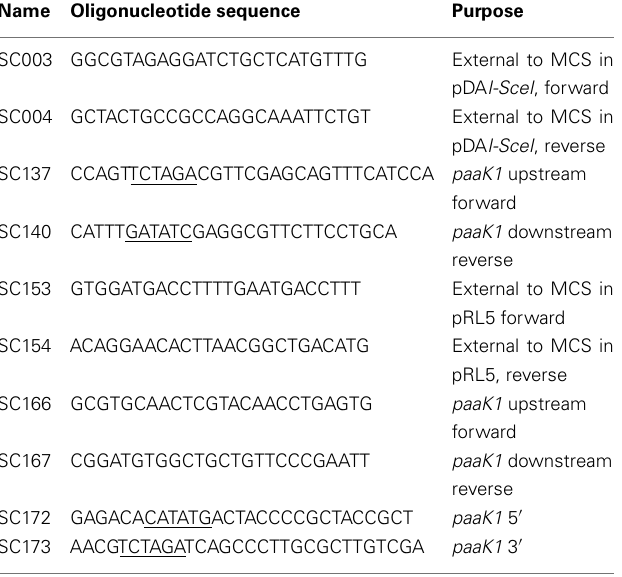
Name Oligonucleotide sequence